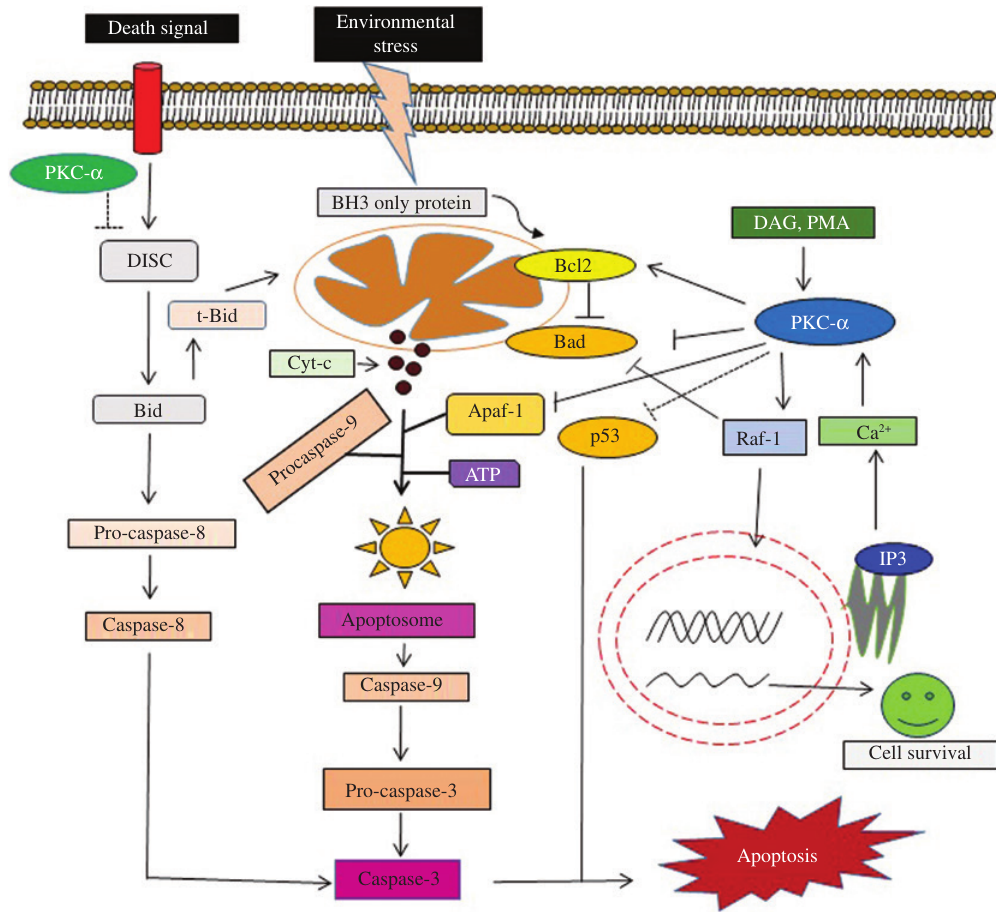
Figure 4: Possible involvement of PKC- α in the intrinsic and extrinsic apoptotic pathways. PKC- α -mediated regulation of apoptosis is partly known. During apoptosis, PKC- α phosphorylates and enhances the activity of anti-apoptotic proteins while downregulating the activity of pro-apoptotic proteins. Further, PKC- α regulates the formation of apoptosome by inhibiting Apaf-1 activity. Another possible target of PKC- α is Raf-1, which promotes cell survival by activating the ERK-MAPK pathway. PKC- α may also prevent apoptosis by modulating the activity of death receptor components and death-inducing signaling complex (DISC) formation, but the mechanism is not determined. However, PKC- α -regulated p53-dependent apoptosis is poorly understood and needs further